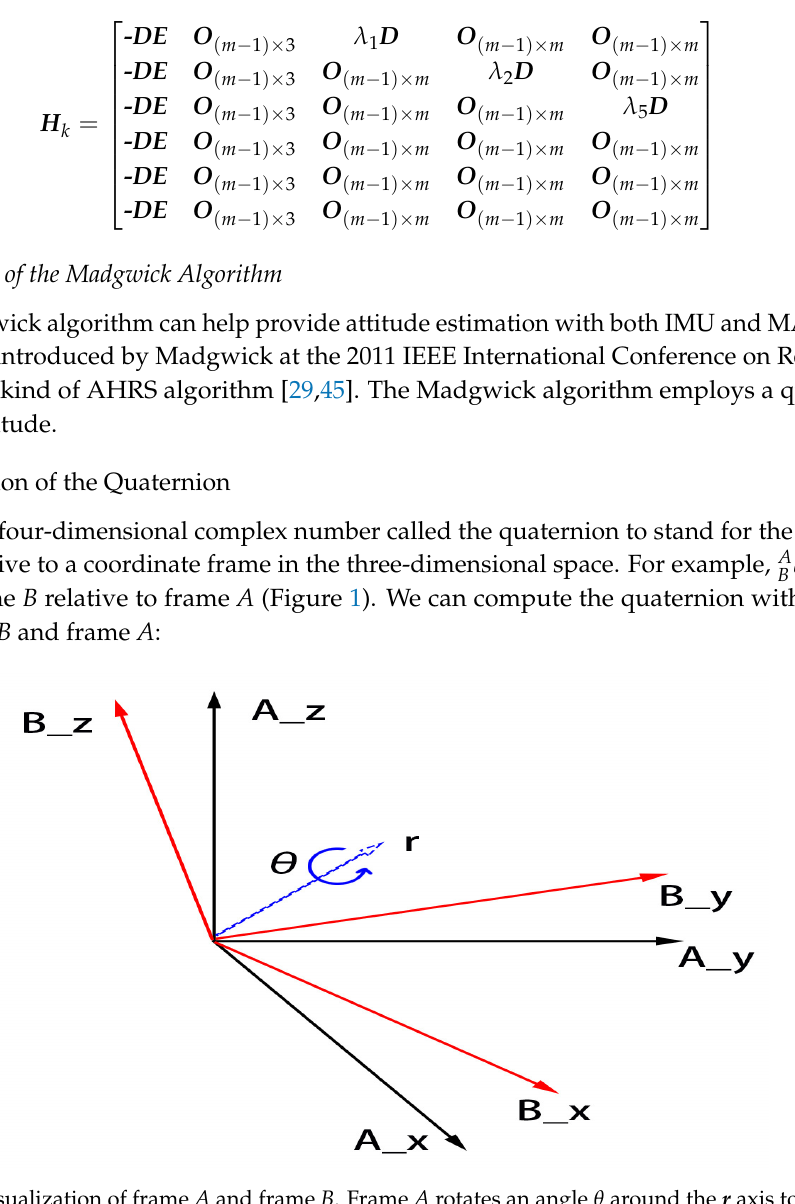
Figure 1. Visualization of frame A and frame B . Frame A rotates an angle θ around the r axis to become frame B